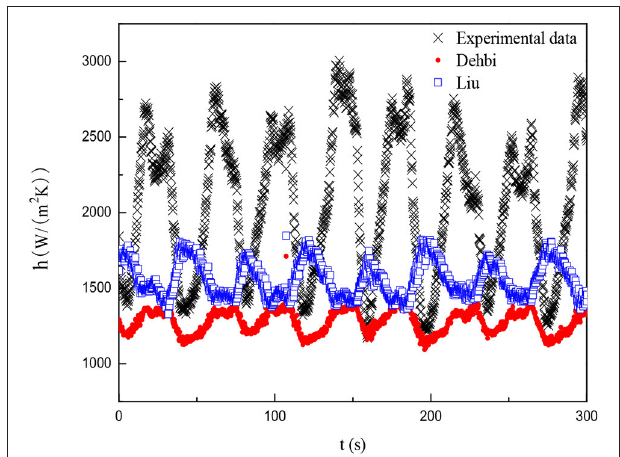
FIGURE 6 | Comparison of correlation against experimental data.